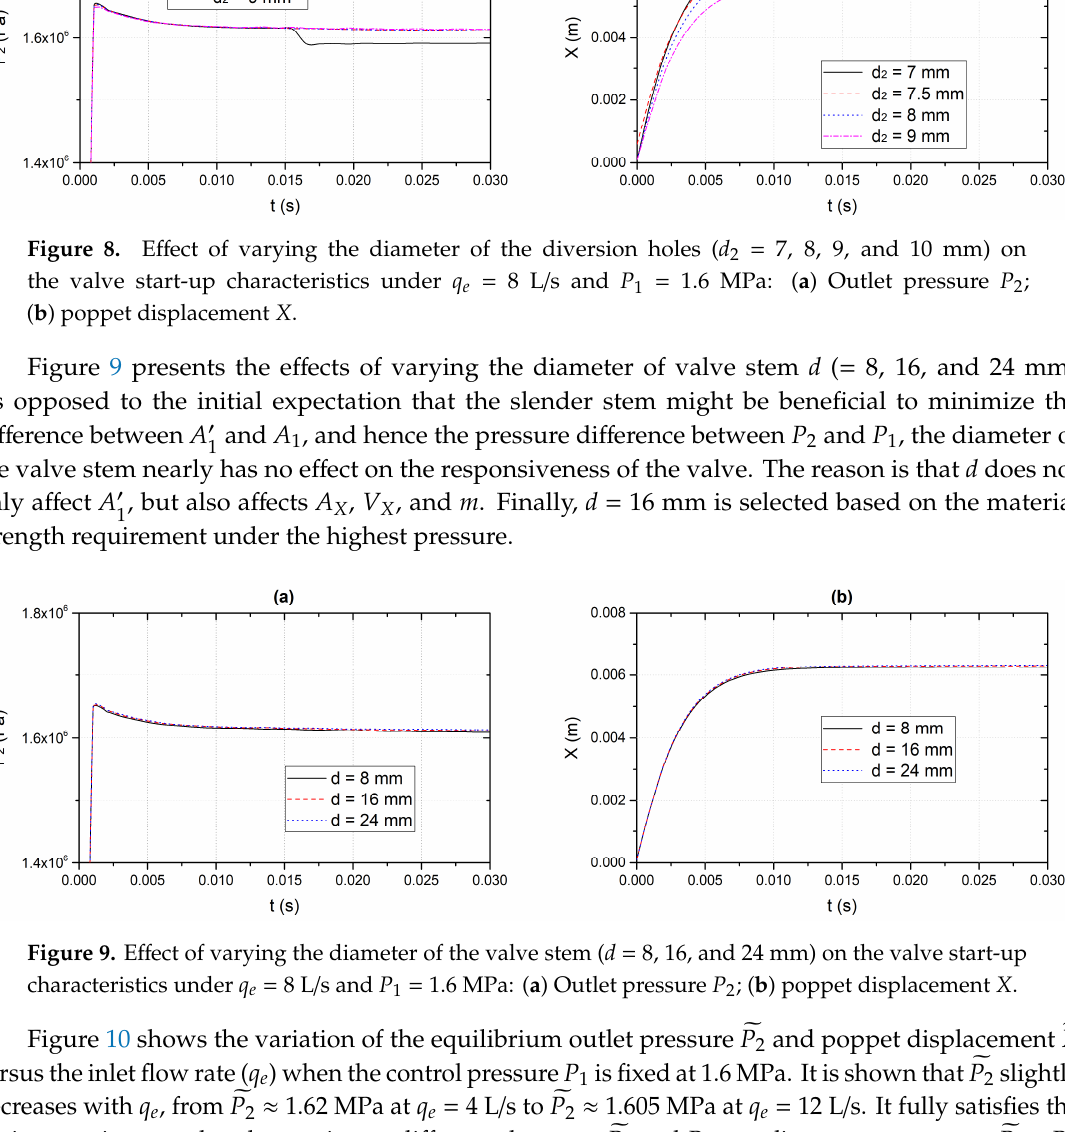
9 of 14 Figure 7. Effect of varying initial conditions (ICs) on the valve start-up characteristics under 𝑞 (cid:3032) = 8 L/s and 𝑃 (cid:2869) = 1.6 MPa: ( a ) Outlet pressure 𝑃 (cid:2870) ; ( b ) poppet displacement 𝑋 . ICs for Case A: 𝑃 (cid:2870) (0) = 0 Pa and 𝑋(0) = 0 mm; ICs for Case B: 𝑃 (cid:2870) (0) = 1.5 MPa and 𝑋(0) = 3 mm; ICs for Case C: 𝑃 (cid:2870) (0) = 1.7 MPa and 𝑋(0) = 5 mm. The present study also investigates the effects of varying geometrical parameters on the valve’s static and dynamic properties. The first parameter is the diameter of the diversion holes 𝑑 (cid:2870) . The four diversion holes connecting the supply chamber and the cushion chamber are introducing some pressure drop between the two chambers, while the small clearance between the poppet body and the cage introduces a high viscous friction force to increase the stability of the valve. When the valve reaches equilibrium, the following relationships hold: 𝑃 (cid:2868) > 𝑃 (cid:3025) > 𝑃 (cid:2870) and 𝑞 (cid:2869) = 𝑞 (cid:2870) . The latter can be